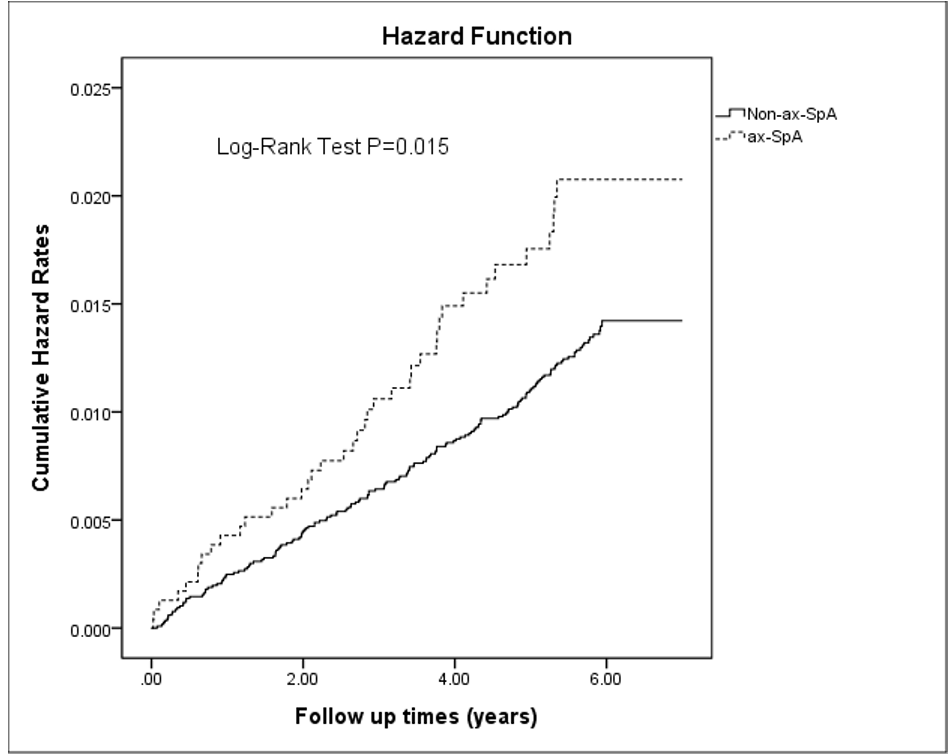
Figure 2. Kaplan – Meier curves for dementia risk between patients with and without axSpA at 7- Figure 2. Kaplan–Meier curves for dementia risk between patients with and without axSpA at 7-year year follow-up.